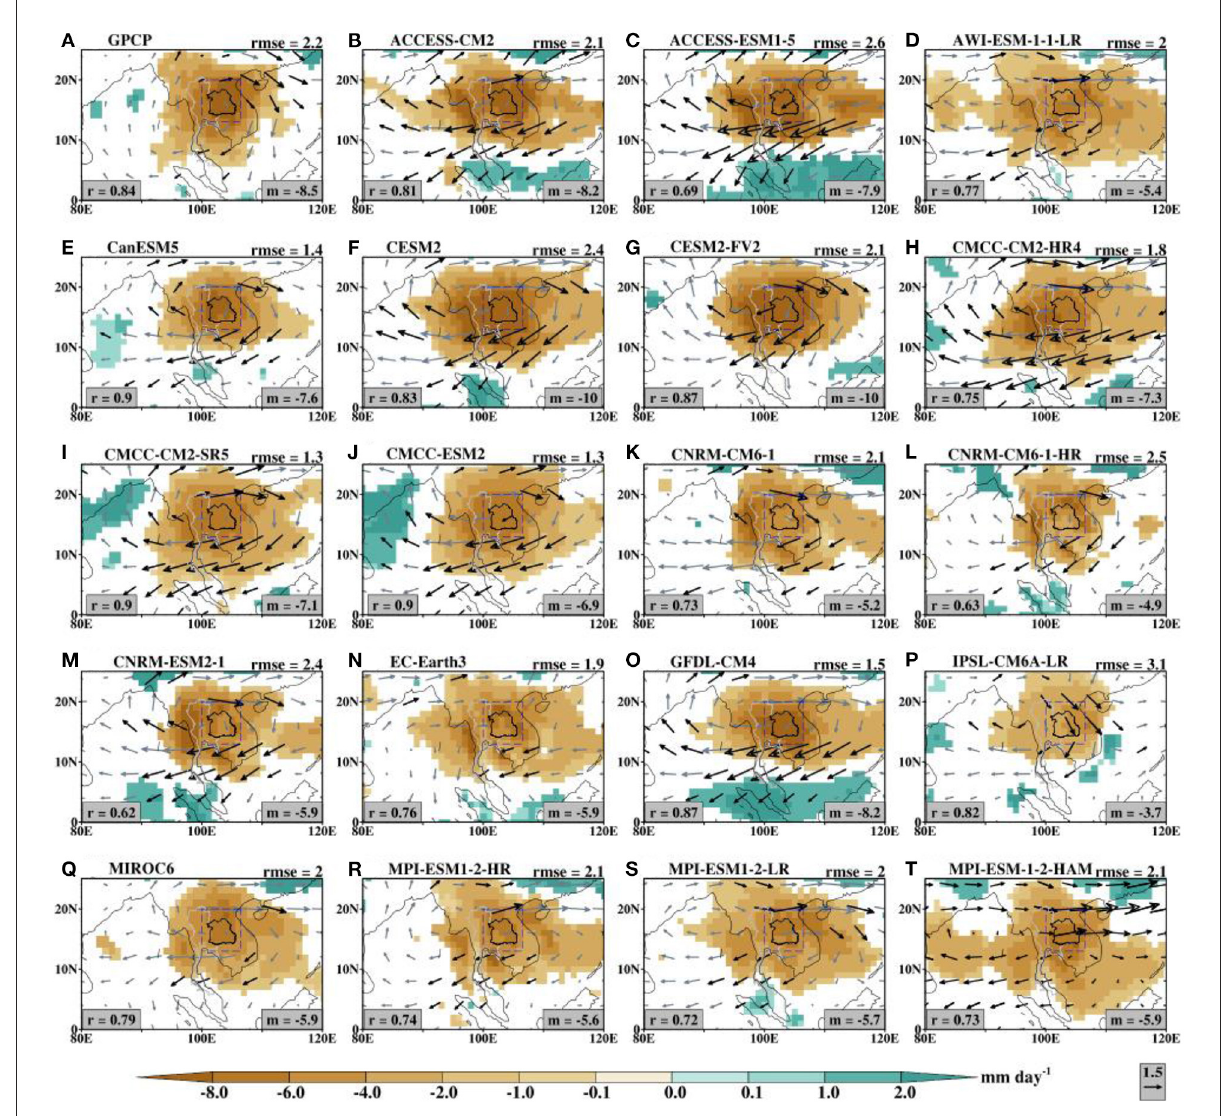
FIGURE2 Dry spells composite anomalies of (A) observed and (B–T) simulated rainfall (shaded) and associated wind field at 850mb level (vectors) for the May–October season during the period 1997–2014. The wind field overlaid on (A) is from ERA5 reanalysis. The value of the Root-Mean-Square-Error (rmse; top right corner) and Spearman correlation [ (R) ; bottom left corner] of rainfall anomaly are obtained against GPCP as the reference observation. The median value (m) of the rainfall anomaly over the study domain is indicated at the bottom right corner. The values on (A) are for GPCP vs. Aphrodite. Only statistically significant rainfall composites are shown. The black arrows are statistically significant at the 95% level while the slategrey arrows are